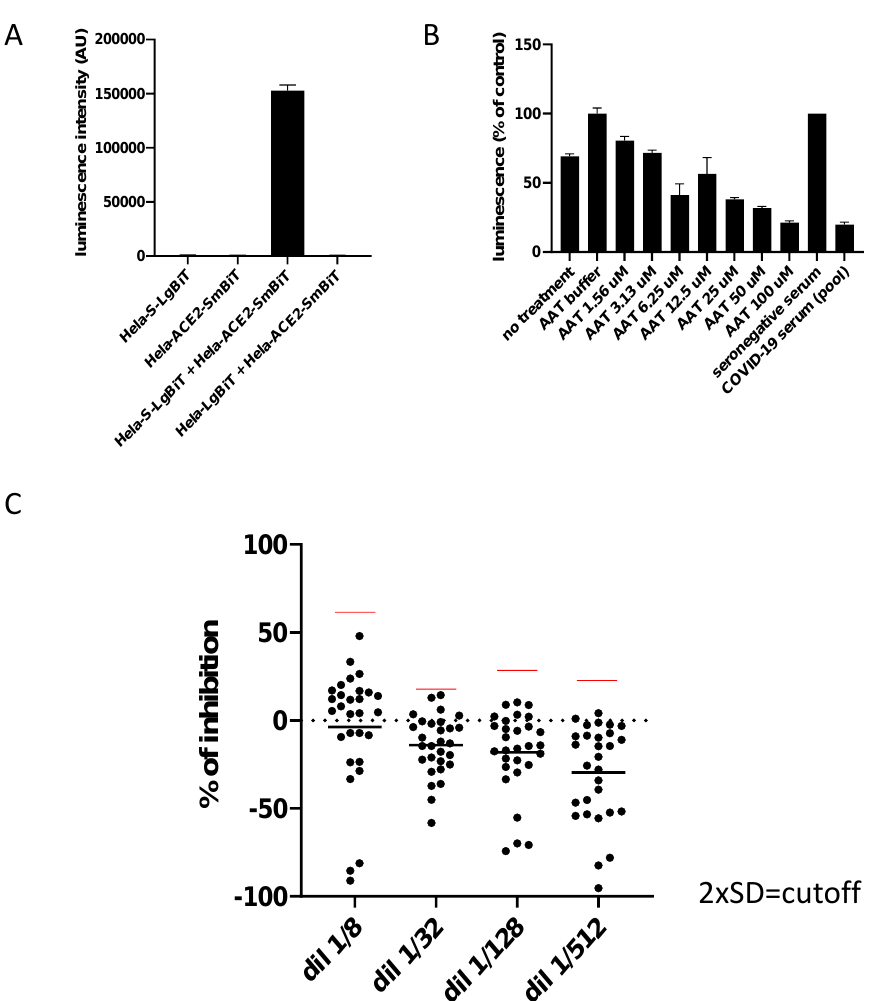
Figure 2. Impact of human seronegative serum on fusion. ( A ) Various combinations of Hela trans- duced or not with S, ACE2, LgBiT or SmBiT were cocultured 24 h in a 96-well plate, prior to the addition of the substrate for luciferase and reading on a luminometer. ( B ) Influence of AAT on cell fusion. Each luminescent signal is normalized with the value in the presence of an internal control, made of another pool of seronegative sera (expressed in %). ( C ) Coculture of Hela-S and Hela-ACE2 in the presence of various dilutions of sera (1/8 to 1/512) from seronegative patients without any COVID-19 history. Each luminescent signal is normalized with the value in the presence of an internal control, made of another pool of seronegative sera. Results are expressed as the percentage of inhibition compared to the internal control